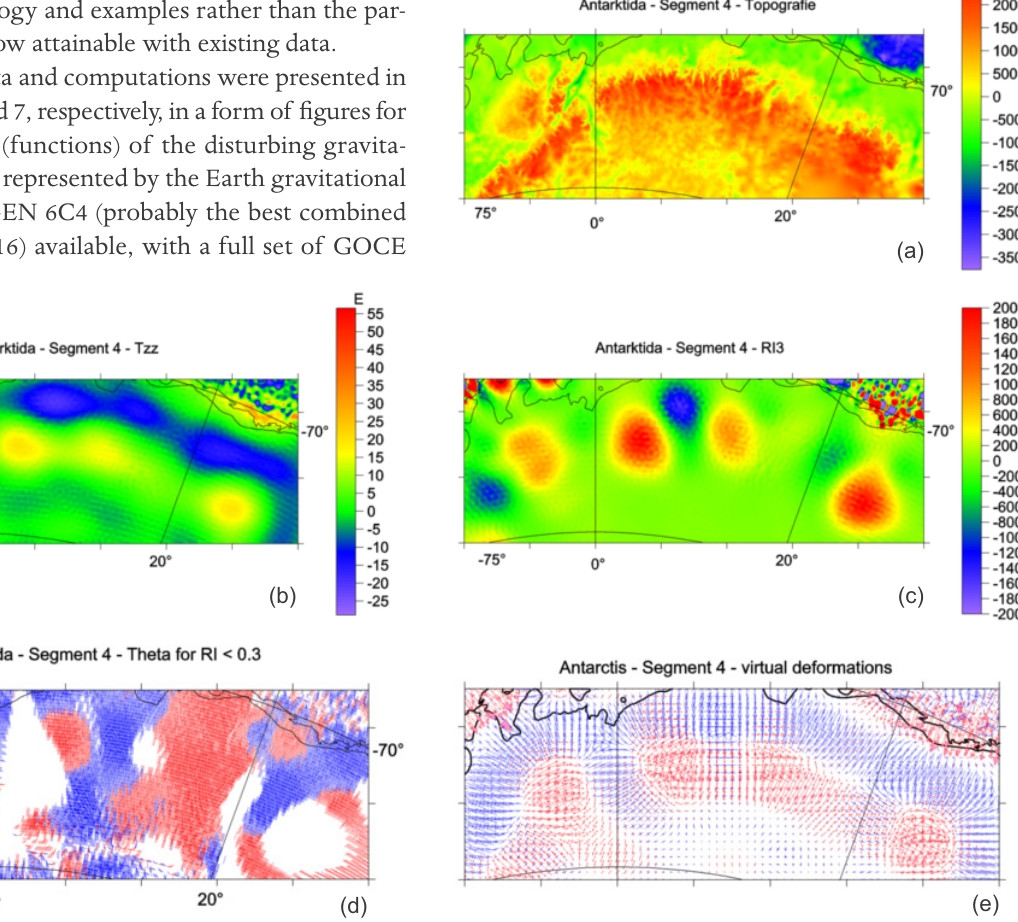
, (c) I , (d) i (for I < 0.3) and (e) vd zz 2